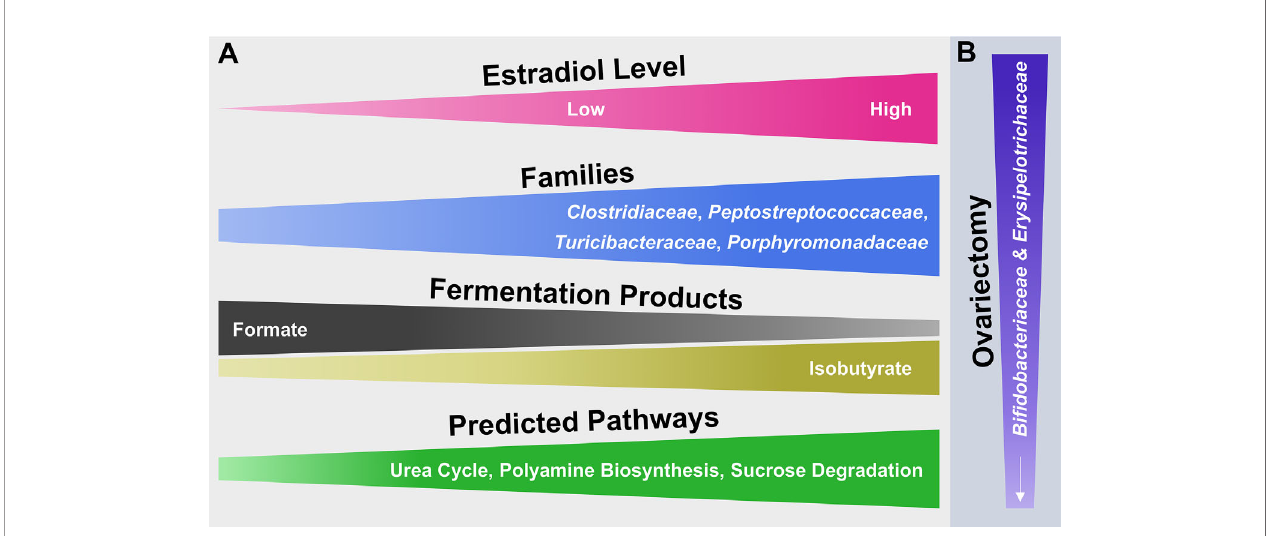
FIGURE 7 | Hypothetical model illustrating the potential impact of E2 including endogenous levels as well as different exogenous doses following ovariectomy on microbial families of the mammalian gut microbiota and their functionality. (A) From left to right, increasing or decreasing width illustrates an increase or decrease in abundance of the respective attribute (e.g., fermentation products). (B) From top to bottom, decreasing width illustrates a decrease in abundance of microbial